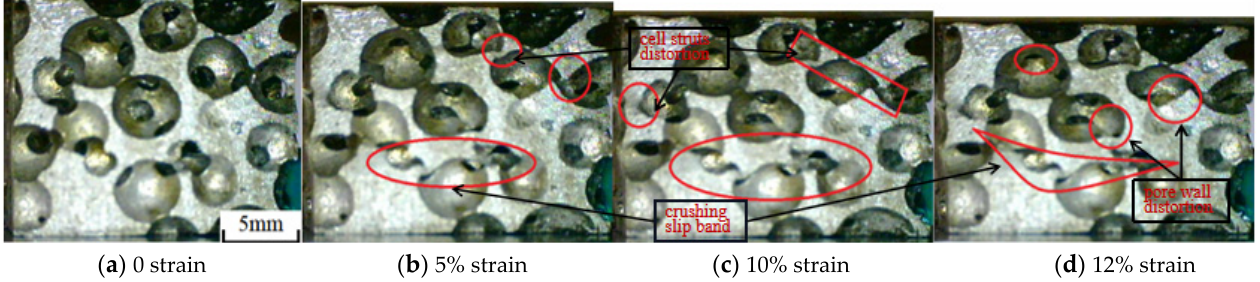
Figure 16. Surface images of the specimen during fatigue test (k = 1.3) : ( a ) 0 strain; ( b ) 5% strain; ( c ) 10% strain ; ( d ) 12% strain .